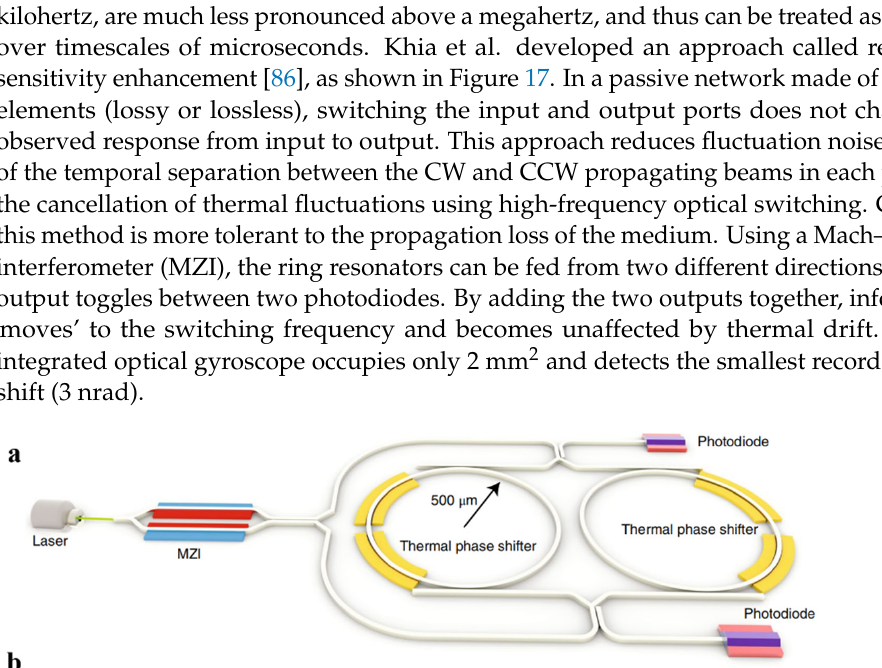
from ref. [49]. Copyright 2017 The Optical Society.